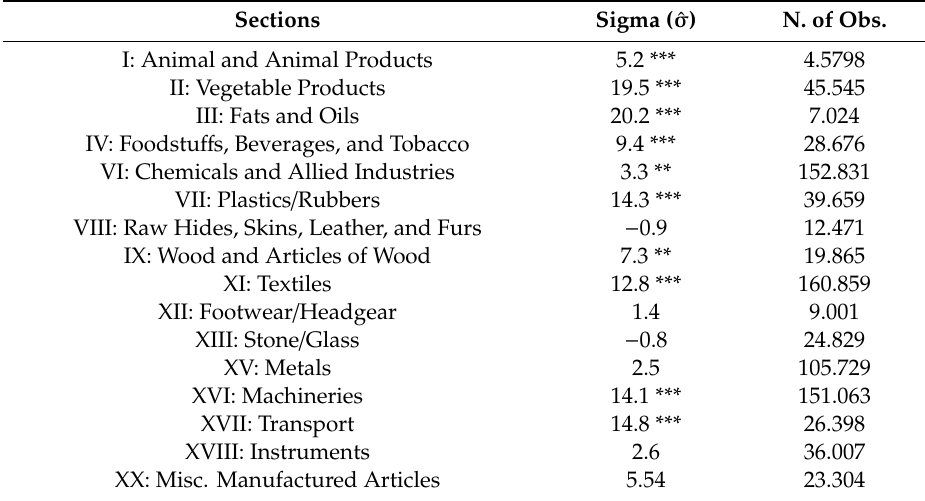
Table 1. Estimated elasticities of substitution by